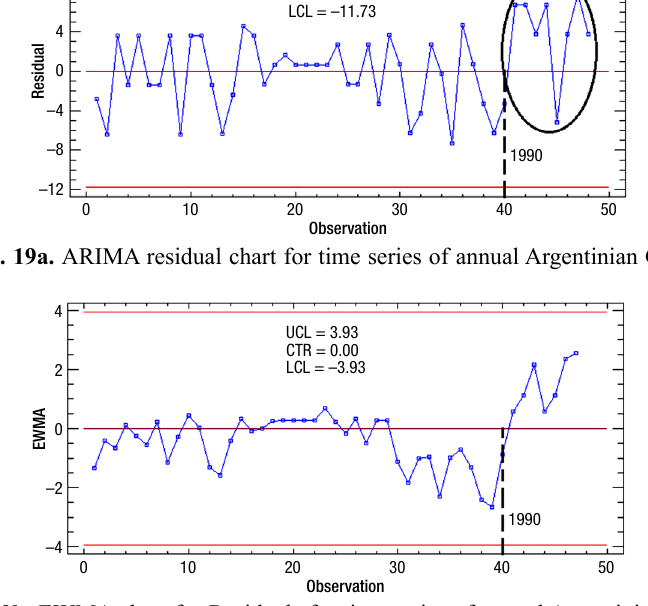
UCL = 11.73 CTR = 0.00